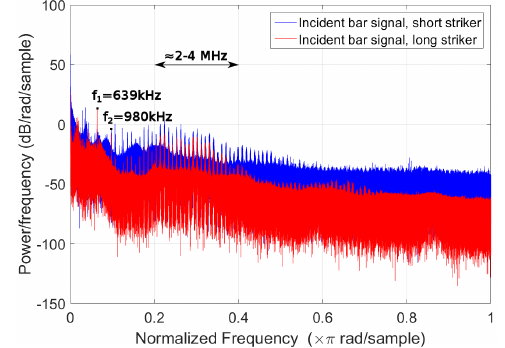
Figure 6. Periodogram of incident signal: l 500 mm (long striker), v s = 24 . 05 ms − 1 (low striker velocity) and l s = 100 mm (short striker), v s = 19 . 32 ms − 1 (low striker velocity)